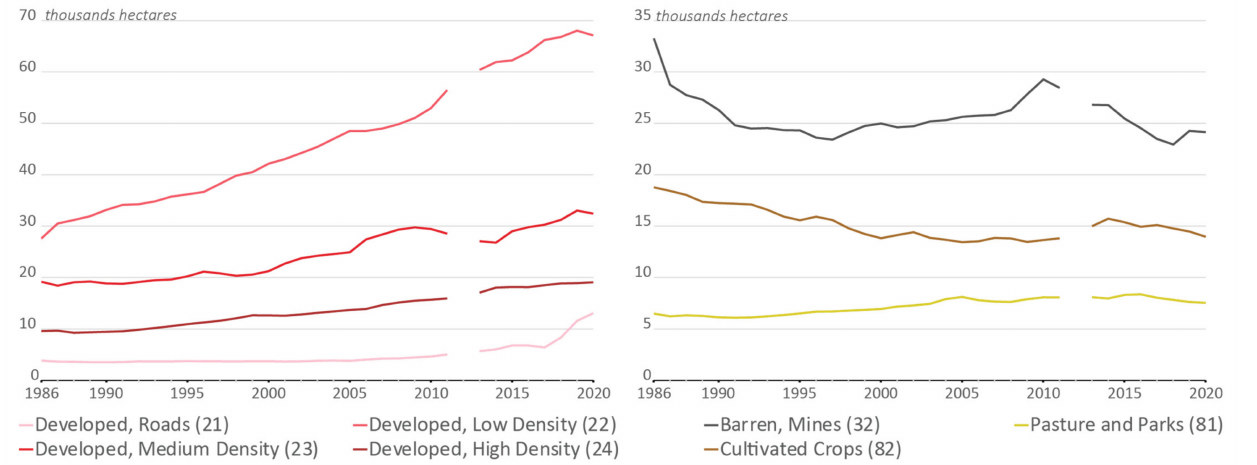
Figure 6. Human-driven land cover changes (1986–2020); note that the gap in the figure corresponds to the year 2012 which was not